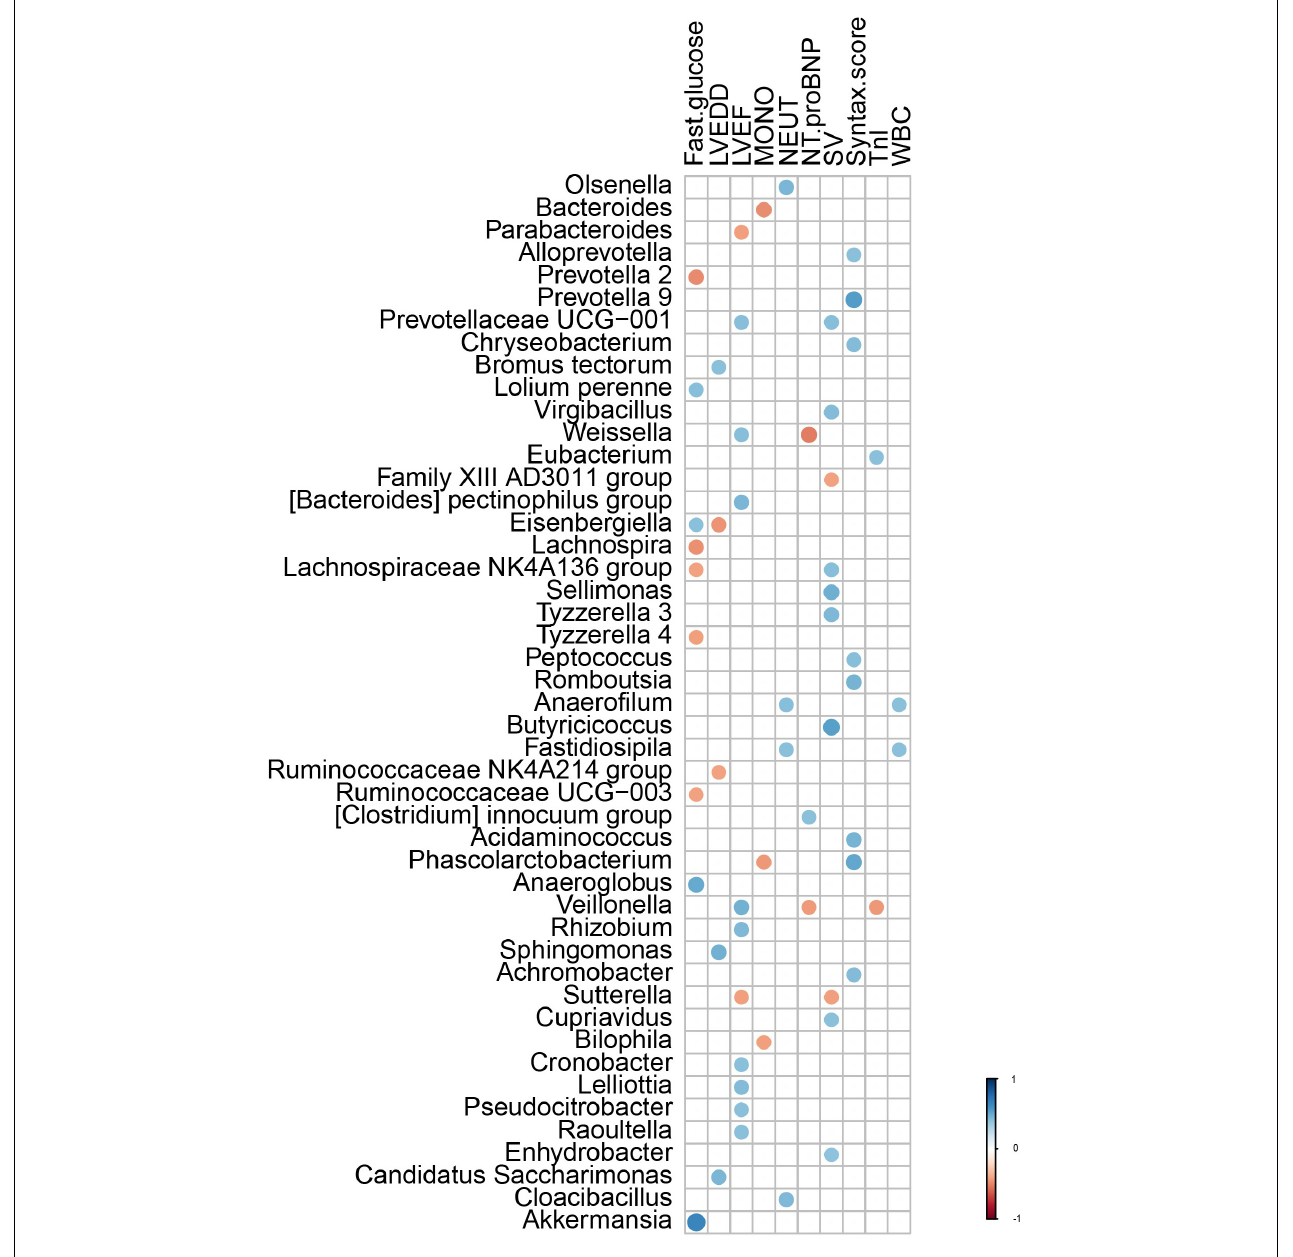
FIGURE 5 | The correlation between the gut microflora and the clinical characteristics with different significance in AMI patients. LVEDD, left ventricular end diastolic diameter; LVEF, left ventricular ejection fraction; TnI, Troponin I; NT-proBNP, NT-pro B-type natriuretic peptide; WBC, white blood cell; NEUT, neutrophils; LYMPH, lymphocytes; MONO,